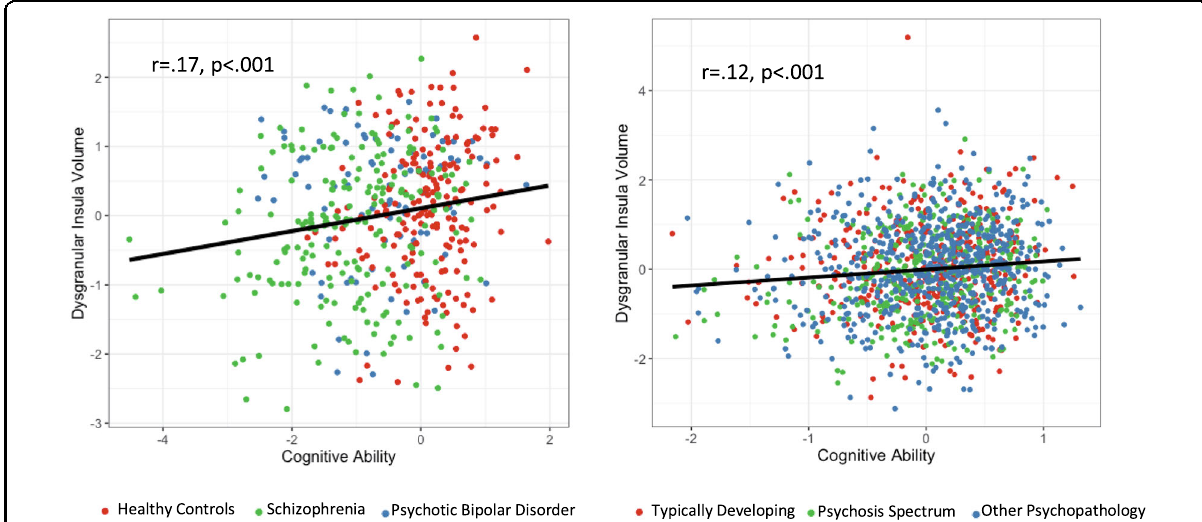
Fig. 3 Dysgranular volume and cognition. Correlation between dysgranular volume and cognitive ability in the psychotic disorder and PNC cohorts. Volume is presented as a marginal mean controlling for group, age, gender, and total intracranial volume (TIV). In both groups, lower dysgranular insula volume was associated with worse overall cognitive ability, with highly similar effect